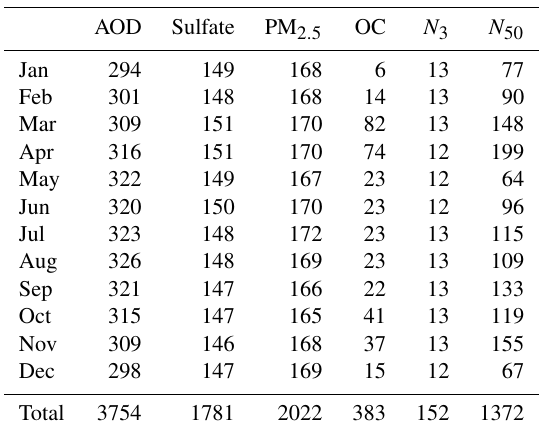
Table 1. The number of monthly aggregated grid-box measure- ments for each variable in each month. The total number over all months and all variables is